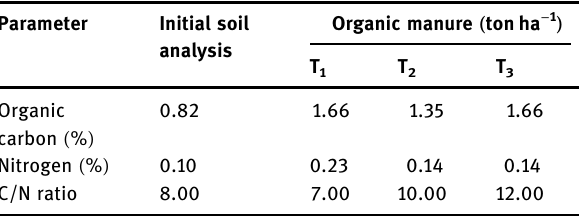
Table 1: The improvement of chemical soil properties due to